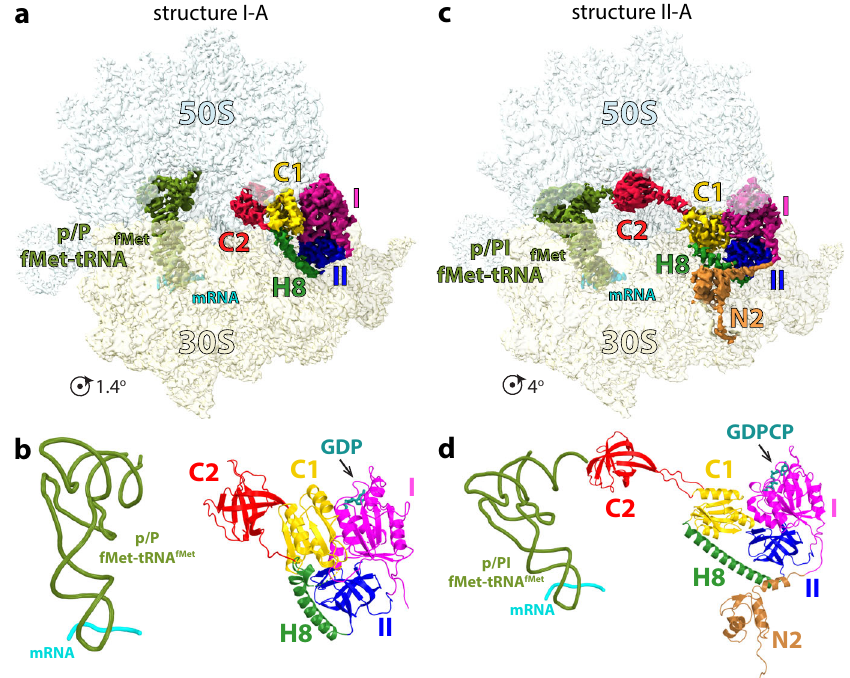
Fig. 1 Cryo-EM structures of the 70 S ribosome initiation complex bound to IF2-GDP and IF2-GDPCP. a Cryo-EM map of the Pseudomonas aeruginosa 70S-IC bound to compact IF2-GDP in structure I-A. The 50 S and 30 S subunits are shown in light blue and yellow, respectively. The initiator tRNA is green, mRNA is cyan, and domains of IF2 are assigned distinct colors. b Model of compact IF2-GDP in structure I-A. Relative to extended IF2 ( c , d ), the distal tRNA-binding domain C2 (red) collapses onto the core domains of compact IF2. c Cryo-EM map of the 70S-IC bound to extended IF2-GDPCP in structure II-A. d Model of extended IF2-GDPCP in structure II-A. The C2-domain (red) interacts with the fMet moiety of initiator tRNA bound in the p/PI state. The rotation angle of the 30 S subunit in the 70S-IC relative to the non-rotated P. aeruginosa 70 S ribosome 44 is indicated under each map ( a , c ). The N2 sub- domain (brown) of IF2 is only visible in the rotated 70S-IC ( c , d